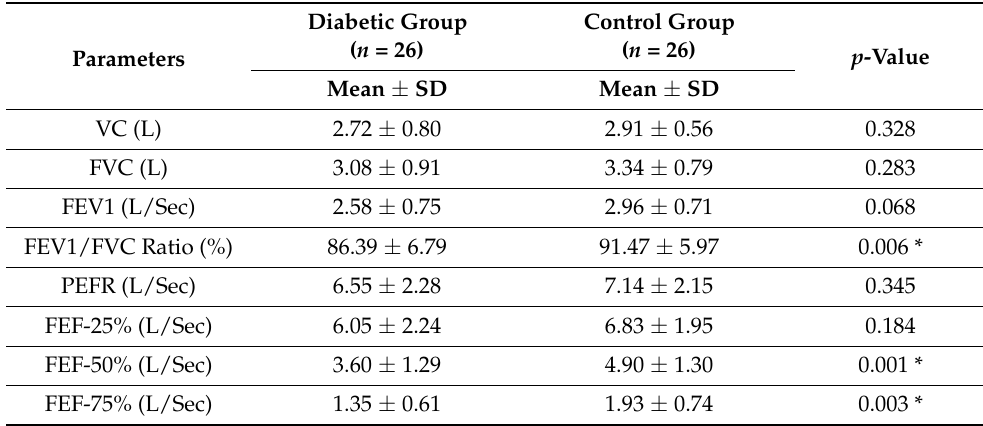
Table 3. Lung function parameters for type 2 diabetic patients with disease duration between 5–10 years compared with their matched